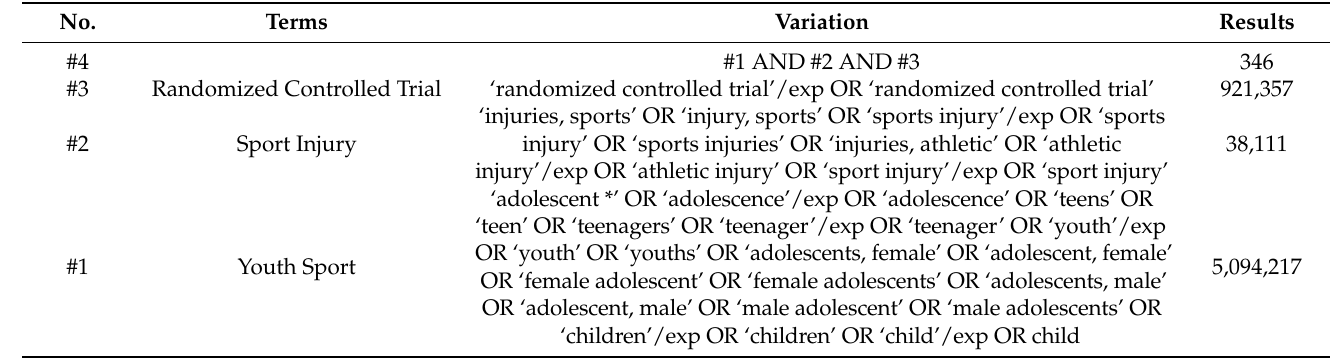
Table A3. Embase Search Terms and Variations Used for Systematic Search.